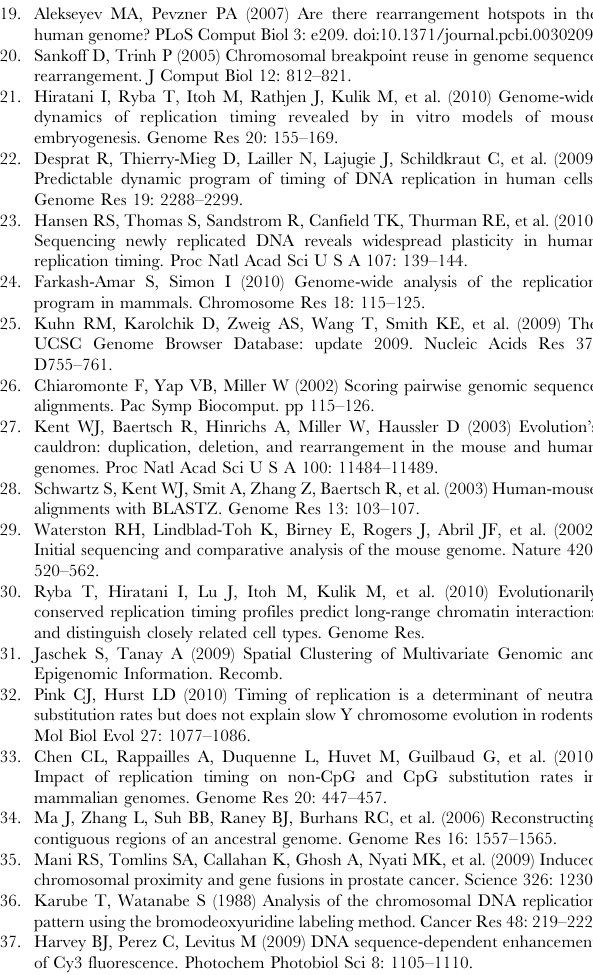
Figure S15 Using an outgroup to identify certified rearrange- ment events. We show 4 syntenic block (colored A:green, B:orange, C:light grey, D:dark grey). We connect with dashed lines the homologuos intstances of the same block in different species. On top we demonstrate a simple fusion event. In species S1,S2 and Out (which serves as an outgroup) block A is adjacent to block C and block B is adjacent to block D. In species S3,S4 we have block A adjacent to block B (while blocks C,D got translocated to another place and are not shown). We therefore assign with high confidence a fusion event of A,B to the red branch in the phylotree. On the bottom we show a simple separation event. In that case the outgroup agrees with the species S3,S4 and we therefore regard the event as a separation event of A,B, and again we assign it to the red edge. Table S1 List of breakpoints. List of 880 fusion events used in the analysis. For each fusion we show the associated branch in the